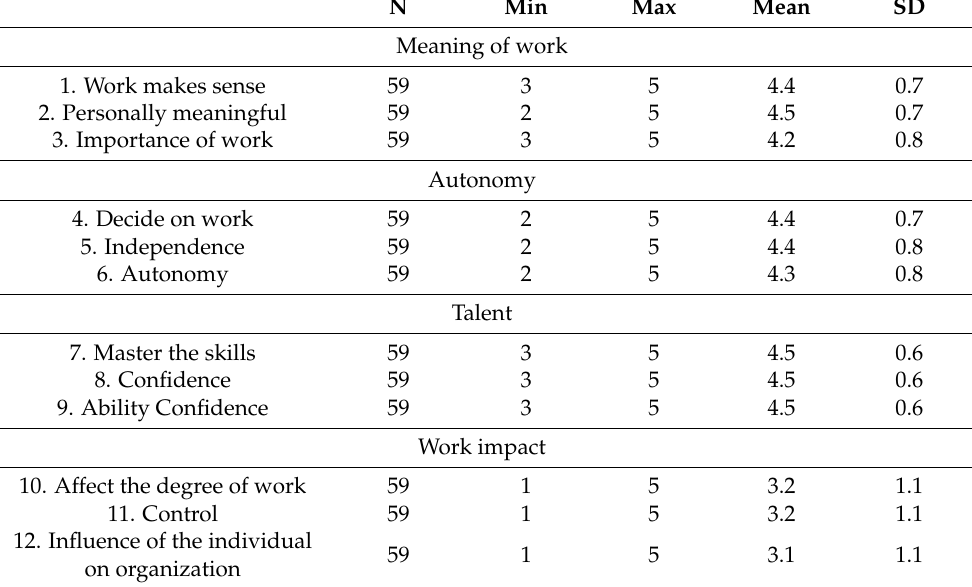
Table 4. The work attitude of reflexologists.